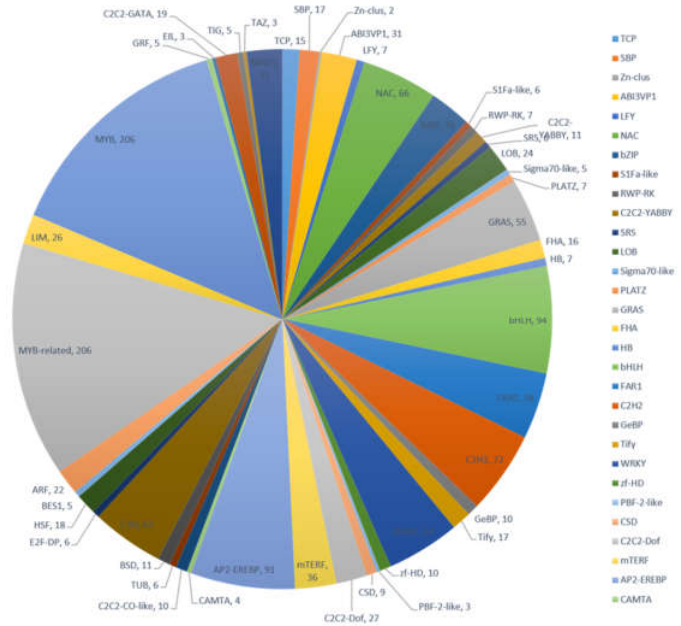
Figure 3. Functional classification and pathway assignment of assembled unigenes by KEGG.